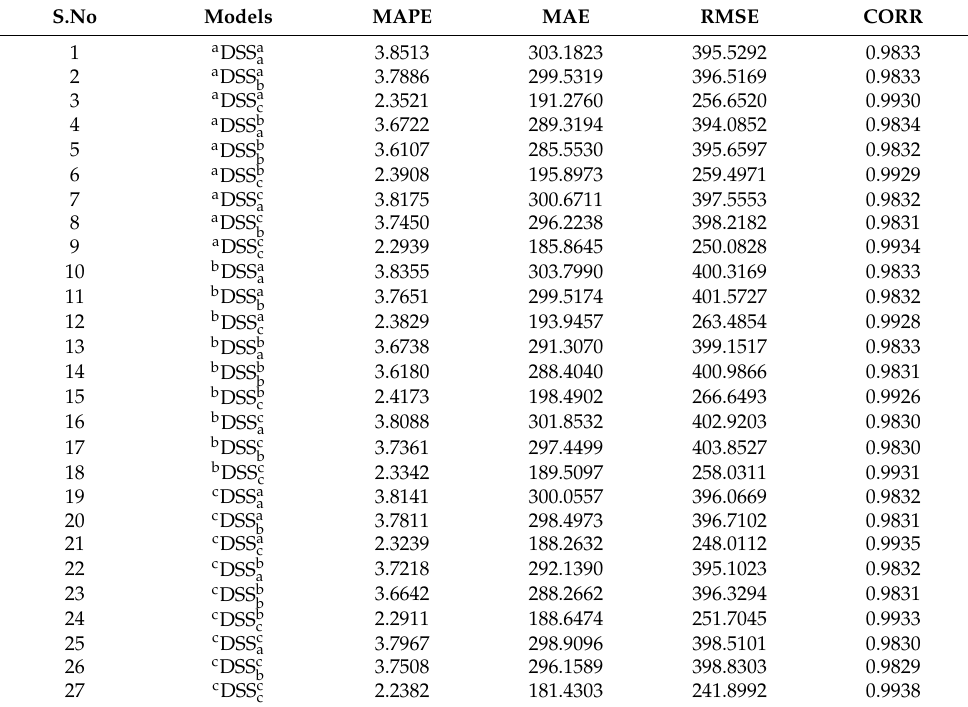
Table 1. Pakistan’s electricity consumption (kWh): out-of-sample one-month-ahead average forecast error for all combined models with the DSS method.